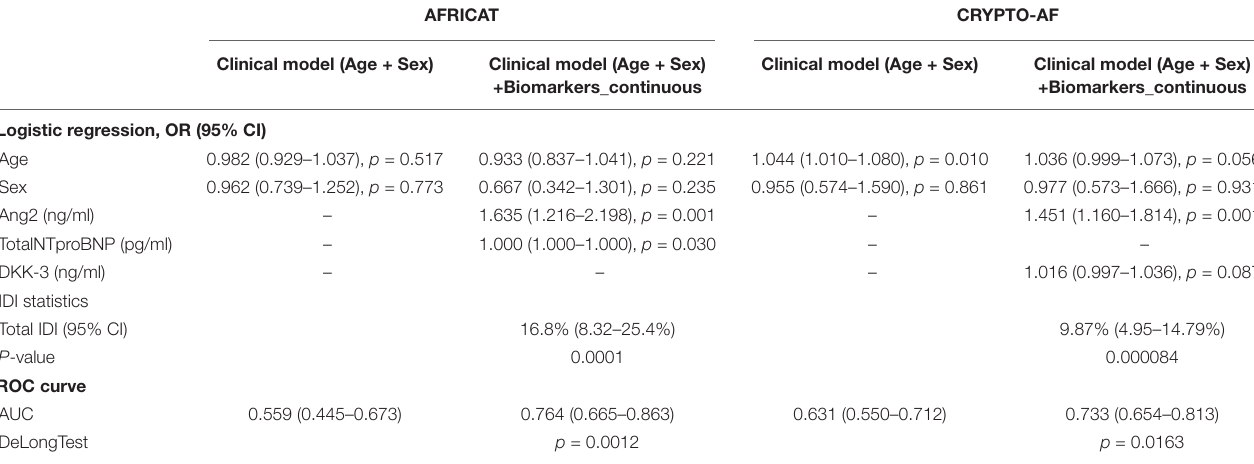
TABLE 3 | Logistic regression analyses and additional predictive value of blood biomarkers as continuous variables in the AFRICAT and the CRYPTO-AF